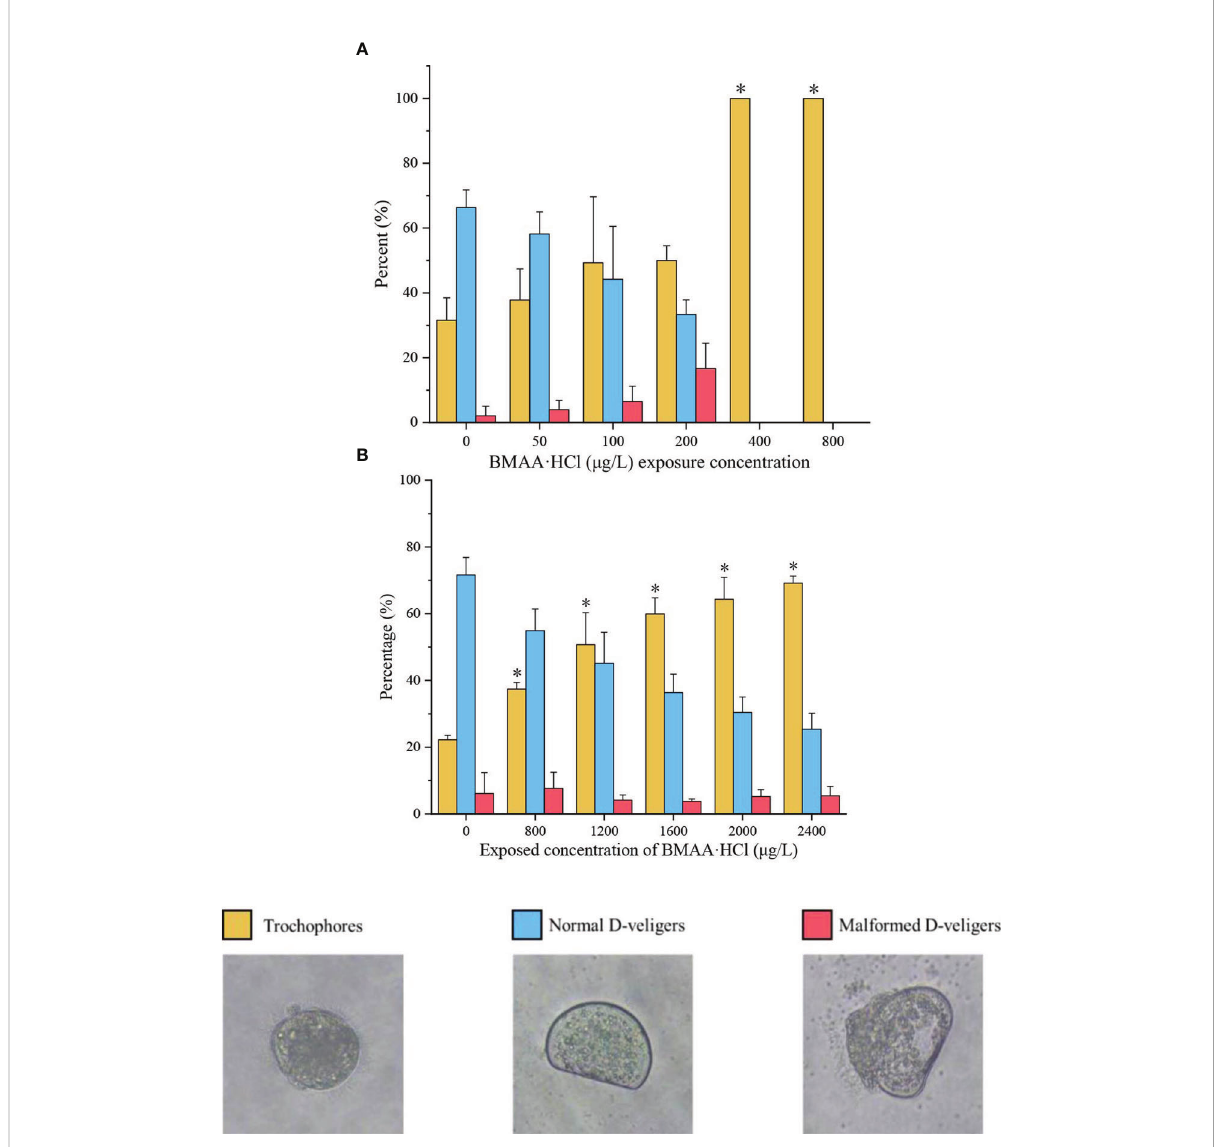
FIGURE 1 Percentage of trochophores, normal D-veligers, and malformed D-veligers of mussel ( Mytilus galloprovincialis ) at 48 hours post fertilization (HPF) (A) and oyster ( Magallana gigas ) at 24 HPF (B) in the BMAA exposure experiments. Note: An equivalent volume of 2 mM HCl used in the highest BMAA exposure treatments was added into the culture wells as a solvent control, which was labeled as a zero concentration of BMAA. Only the percentage of trochophores between control group and BMAA exposure treatments were statistically analyzed. An asterisk indicates the results were signi fi cantly difference at p <